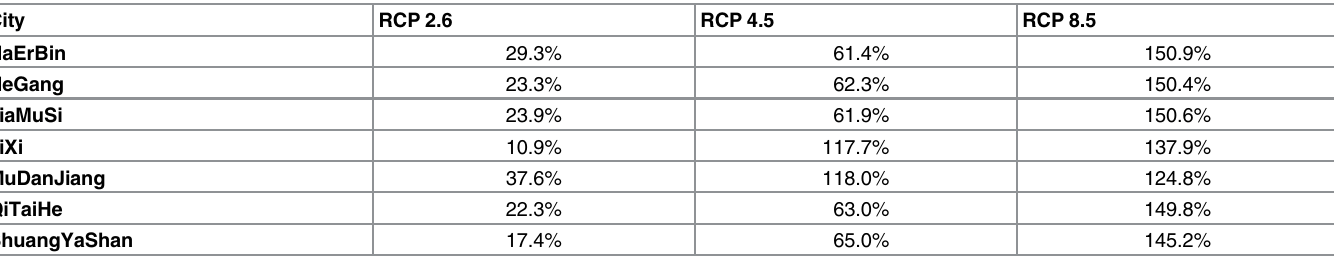
Table 4. Spatial change of CH 4 emissions compared with the average value of 2000s under RCP